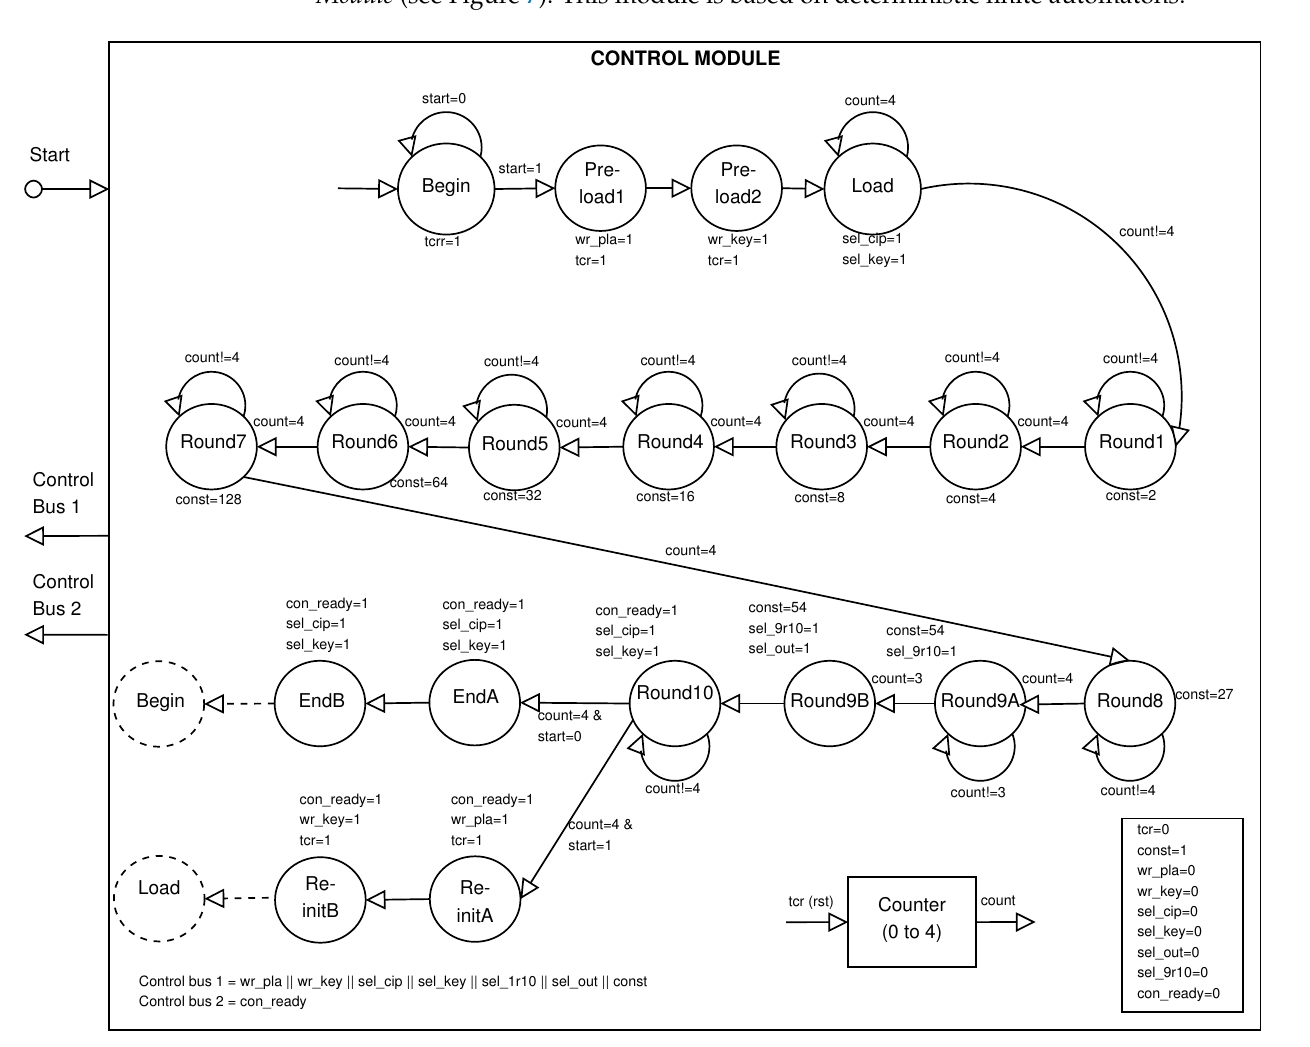
Figure 7. Block diagram of the Control